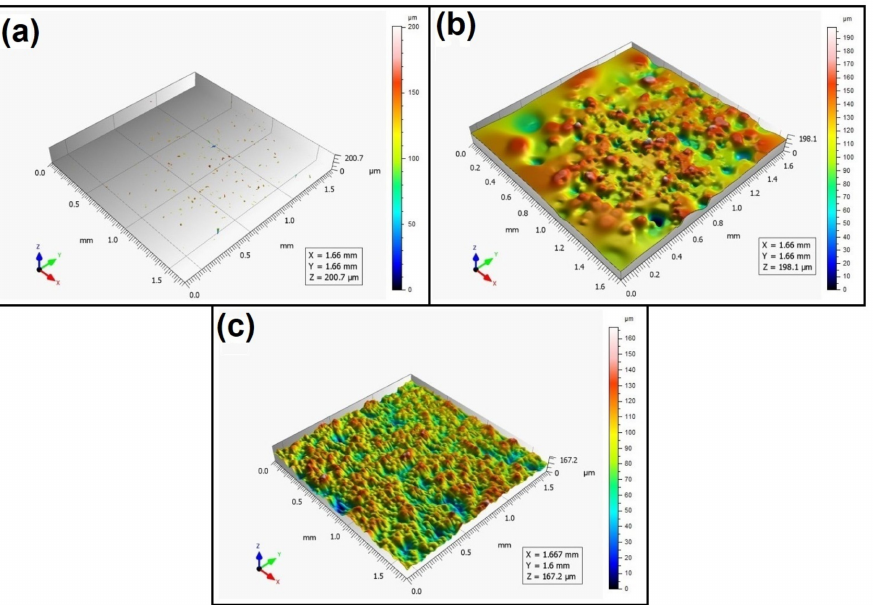
Figure 3. Surface topography of the element 3D printed using SLS technology (Pd = 0 ◦ ). ( a ) Talysurf CCI—without after filling non-measured points, ( b ) Talysurf CCI—after filling non-measured points, ( c ) Talysurf PGI